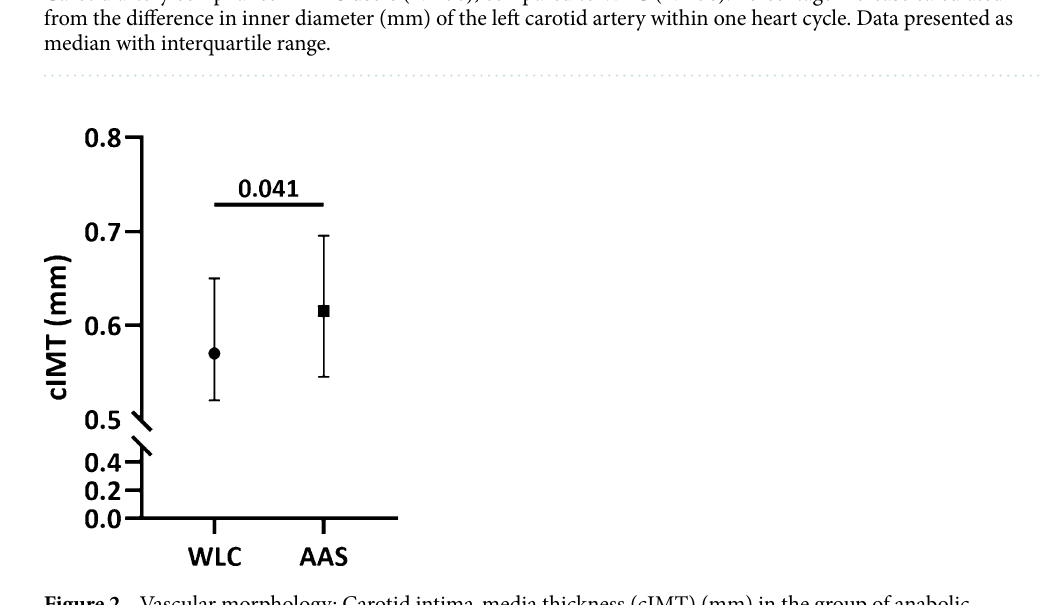
Figure 2. Vascular morphology: Carotid intima-media thickness (cIMT) (mm) in the group of anabolic– androgenic steroid (AAS) users (N = 56) compared to the WLC (N = 67). Data presented as median with interquartile